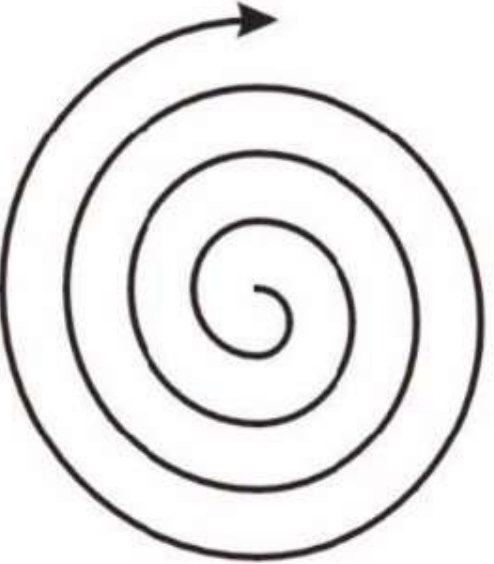
Figure 3: Pacha . Source: Taipe